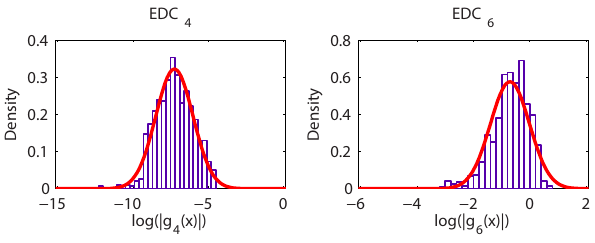
Figure 3. Distribution and Gaussian fit for EDC 4 and EDC 6